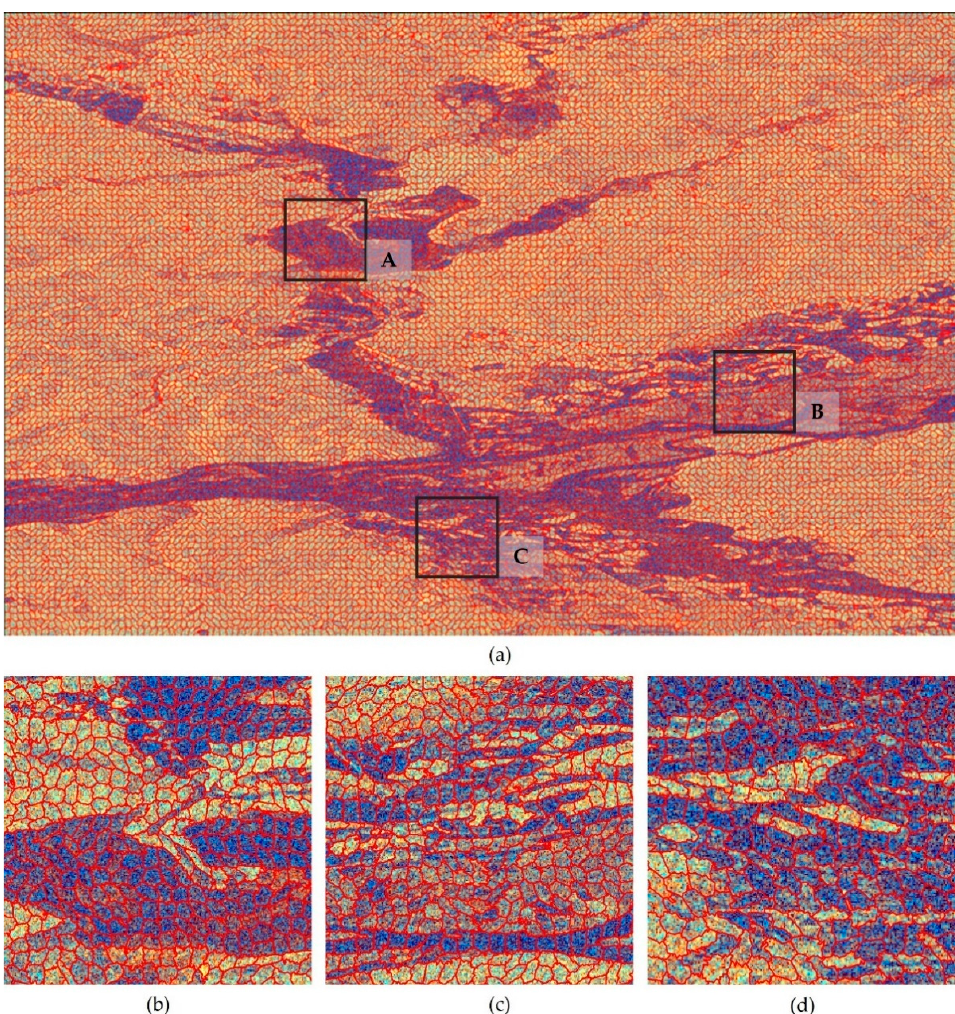
Figure 5. Over-segmentation results of study area 1. ( a ) General view; ( b – d ) are enlarged views of A, B, and C in ( a ), respectively.